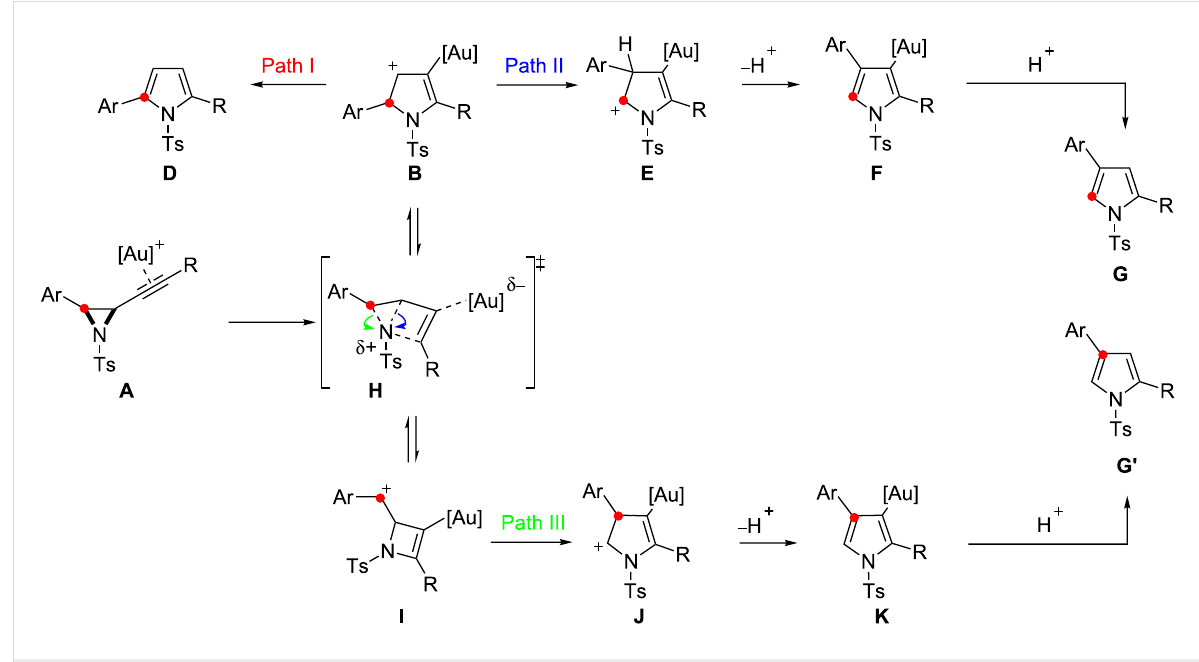
Scheme 11: Revised mechanism for the formation of 2,4-isomers by skeletal rearrangement.